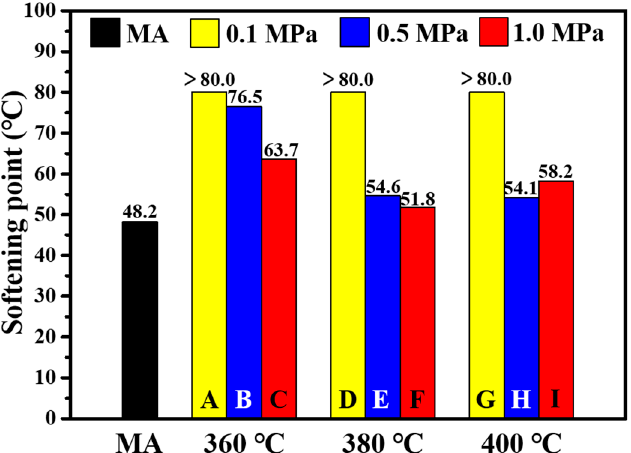
Figure 3. Softening points of matrix asphalt (MA) and PPW-modified asphalt (PPWA).